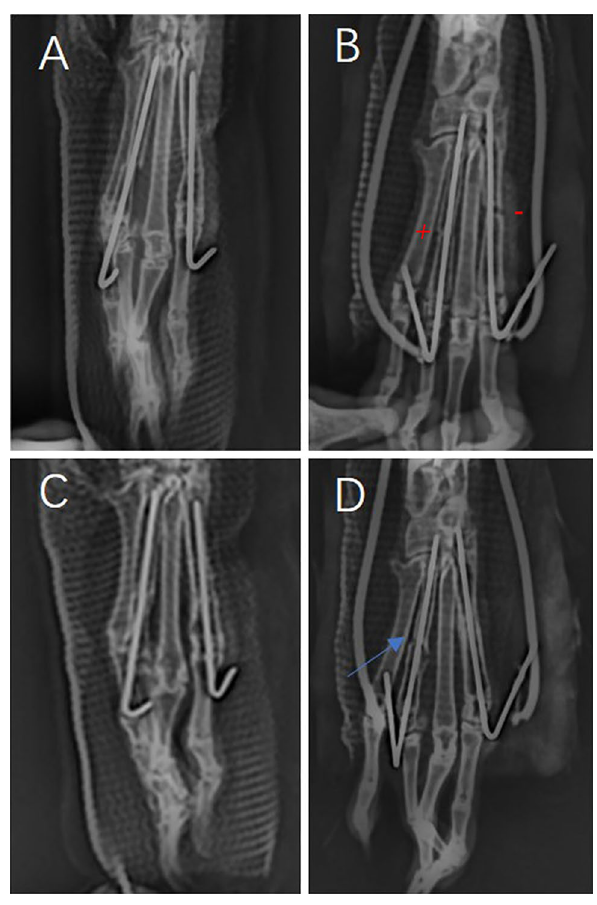
Figure 5. ( A , B ) Toe DR images one day after fracture; ( C ) toe DR image 1 month after surgery in the control group, where the fracture line had disappeared; ( D ) toe DR image 1 month after surgery in the electrical stimulation group, where the fracture line indicated by the arrow is obvious (N ≥